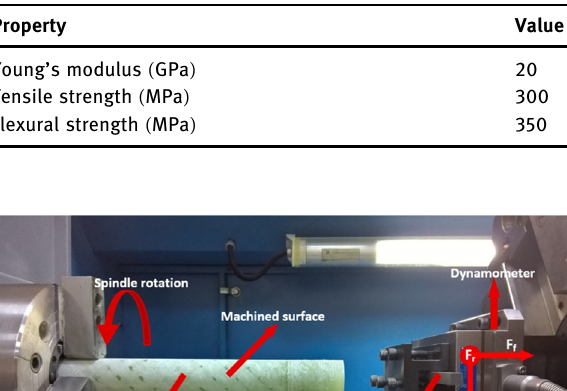
Table 1: Mechanical properties of GFRP